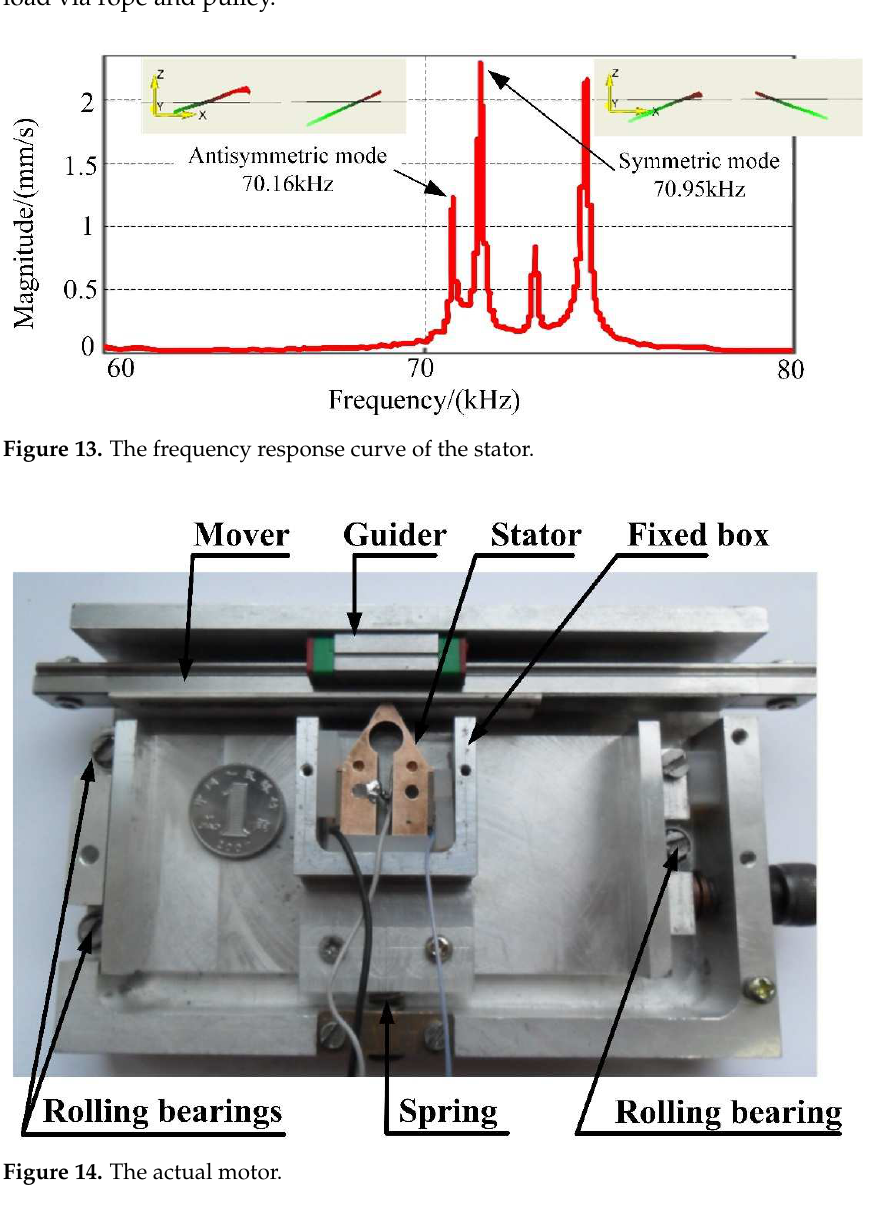
Figure 15. Output characteristic test system and laser interference motion test system. The experiment was conducted inside a Class 100,000 cleanroom. The reflector moves simultaneously with the mover. The mechanical performance curve is shown in Figure 16. The data were captured when the voltage signal frequency reached 69.95 kHz. In accordance with the mechanical performance curve, the output voltage from the motor was evaluated to be 300 Vp-p under 5 N of load. The maximum speed reached 245 mm/s when no load was applied. The minimum speed in the test reached 25 mm/s when 1.6 N load was applied. This result differed from the simulation analysis, which can be interpreted from the perspective of boundary conditions. The driving tip was under stress from the spring, and a silicone pad was applied to both the lateral and bottom side of the stator to distribute the stress. These factors have resulted in the experimental error comparing to the simula- tion result.